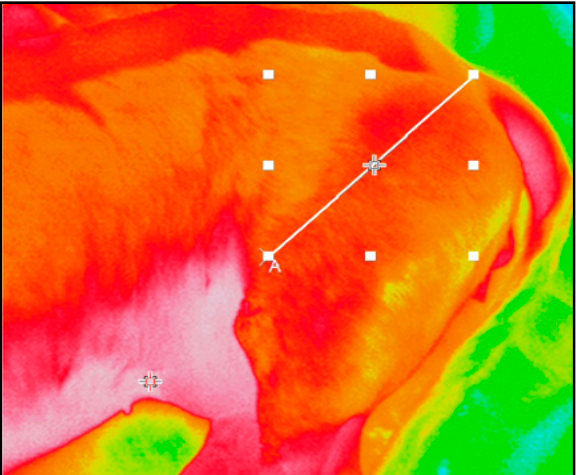
Figure 1. Dachshund, female, 5 yo. Left thigh. In the image squared shaped region (area) of interest (ROI) and diagonal (line) are defined. “A” defines the origin of the diagonal. Data were submitted to descriptive (mean ± standard deviation and median) and analytic statistical analysis in order to investigate any significant variation in the maximum, minimum, and mean temperatures of both areas and lines in T0, T1, and T2. Comparison of temperature differences (maximum, minimum, and mean values) between T0 and T1, T0 and T2, and T1 and T2 within the areas and the lines (diagonals) were performed by use of ANOVA with a Bonferroni post hoc test. The significance level was set for p -values ≤